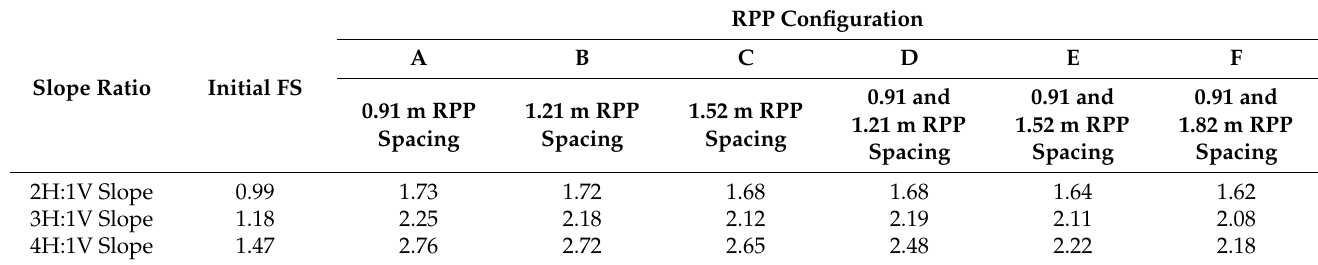
Figure 5. Variations in the FS for different RPP configurations for the three slope ratios of 2H:1V, 3H:1V, and 4H:1V. Table 3. FS values for different RPP spacings in the 2:1, 3:1, and 4:1 slopes.